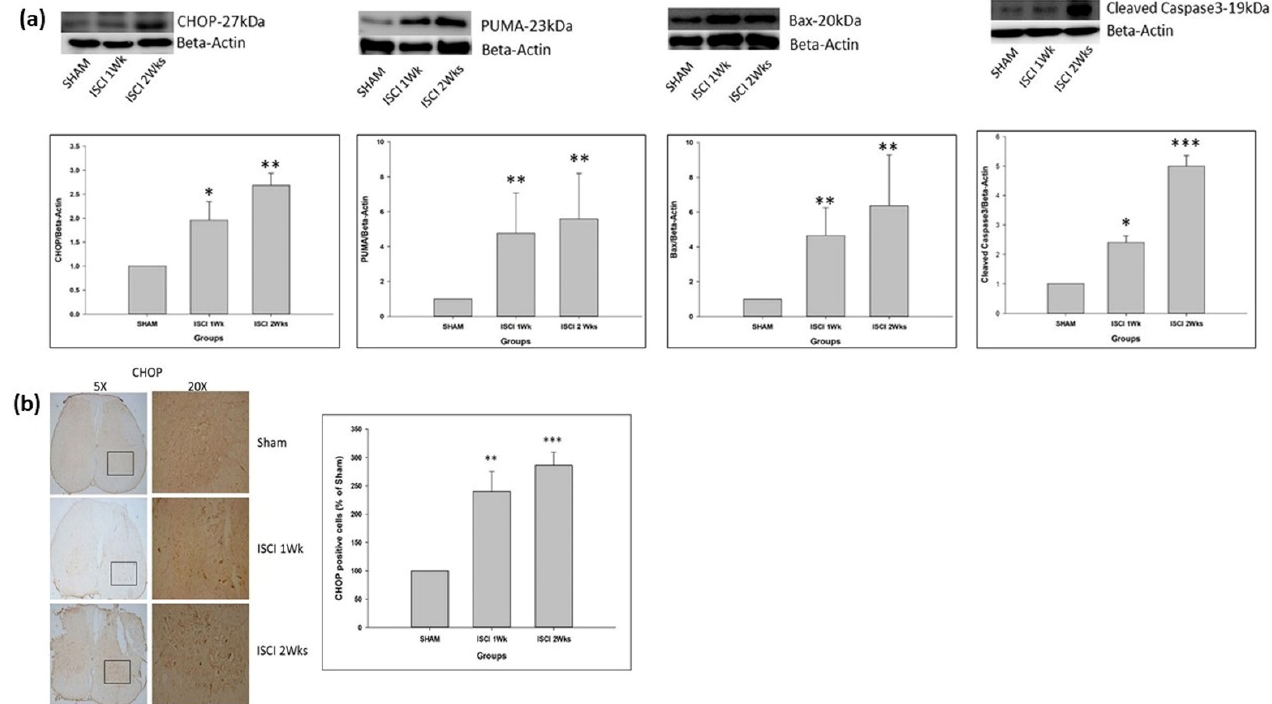
Figure 4. ( a ) Western blot images with the quantification results showing the CHOP, PUMA, Bax, and cleaved caspase 3; ( b ) Immunohistochemistry images with the quantification results showing the CHOP positive cells. Data are expressed as mean ± standard error. * p < 0.05 versus the sham group; ** p < 0.01 versus the sham group; *** p < 0.001 versus the sham group.